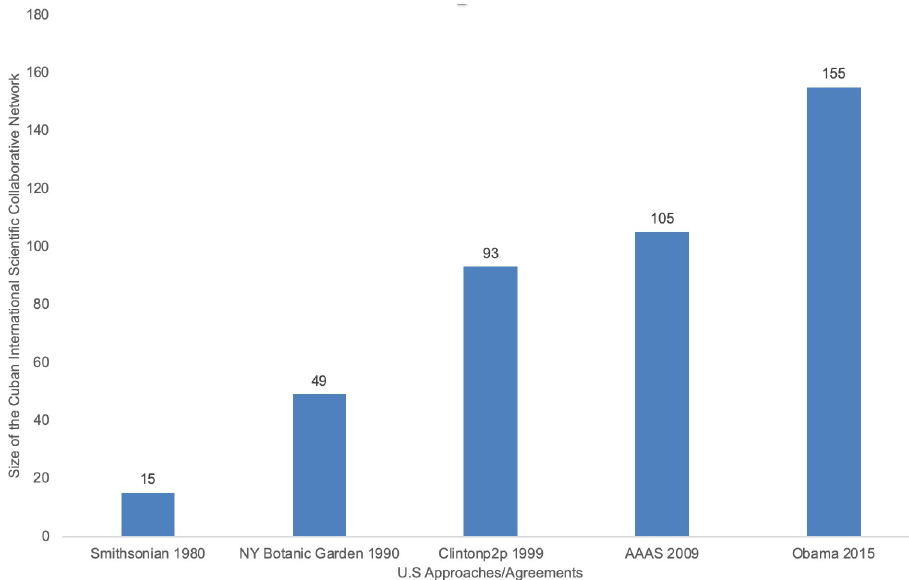
Fig 2. The number of countries in the Cuba–U.S. scientific international collaboration network 1980–2020. The information according to the total number of countries in the U.S.-Cuba co-authored papers in each stage.